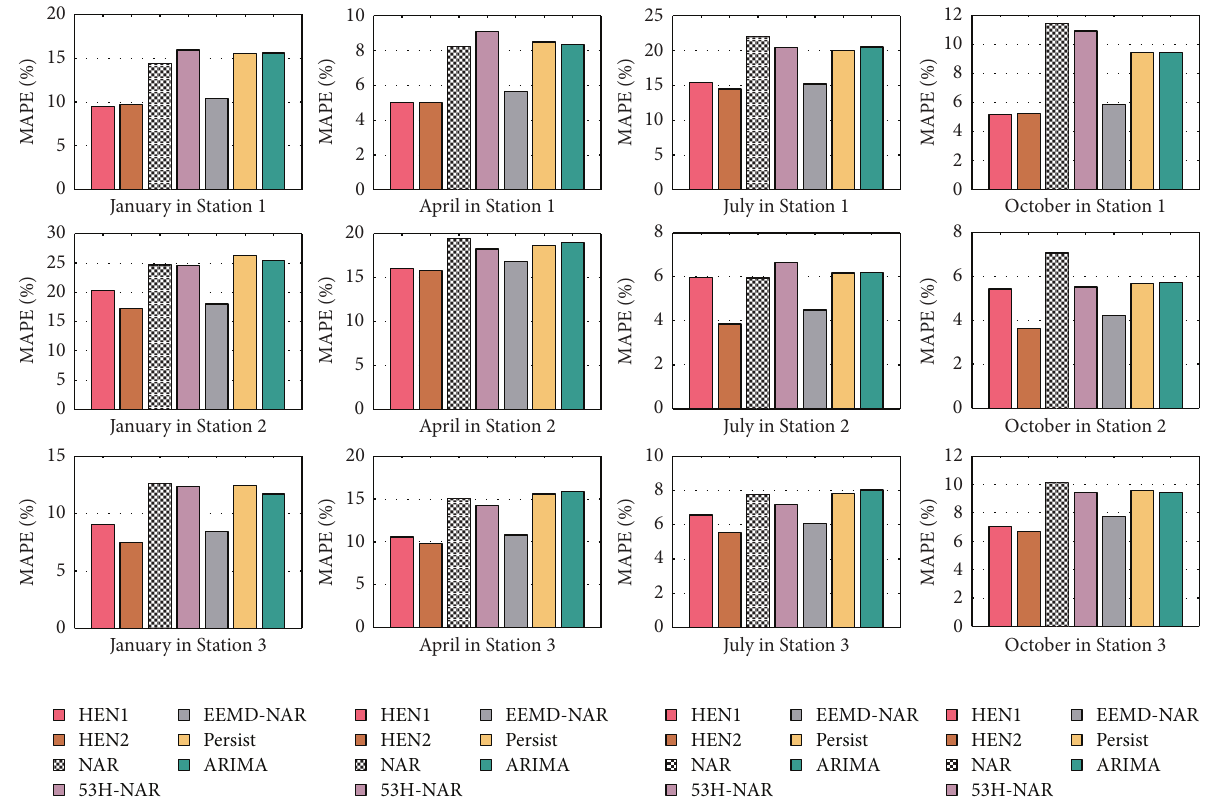
Figure 10: Error comparison among different